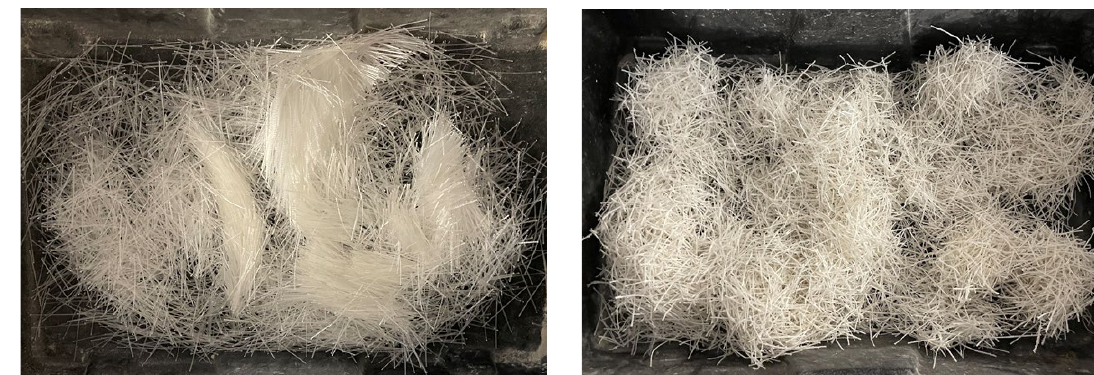
Figure 3. Virgin polypropylene fibers ( left ); recovered polypropylene fibers ( right ).